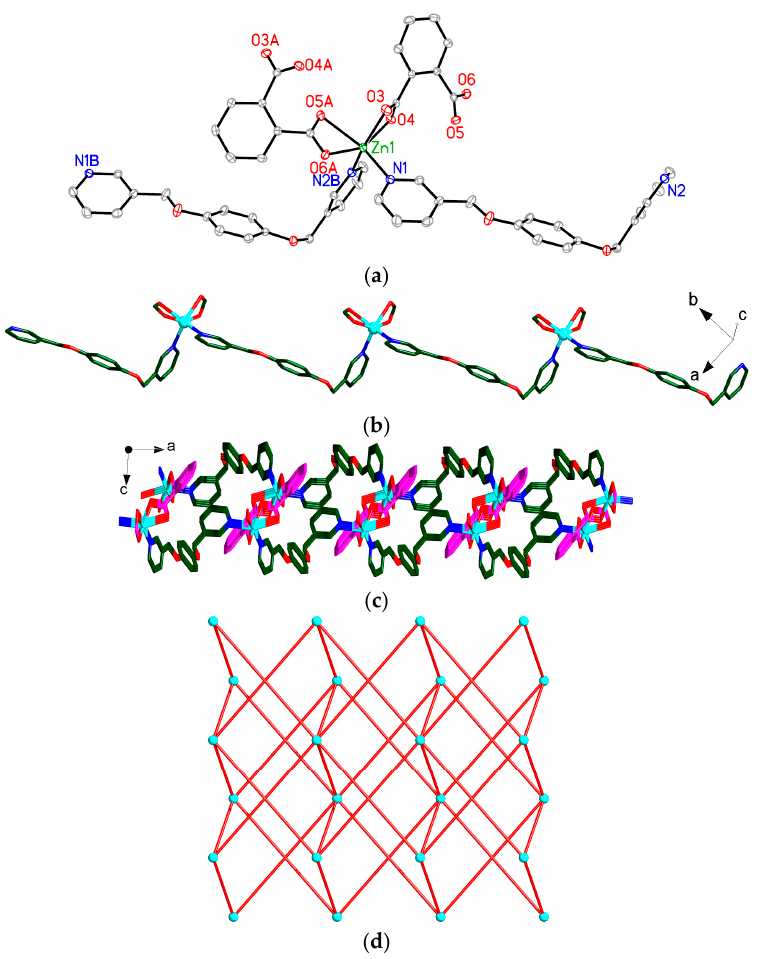
Figure 4. ( a ) View of the coordination environments of Zn center in 3 with labeling schemes.